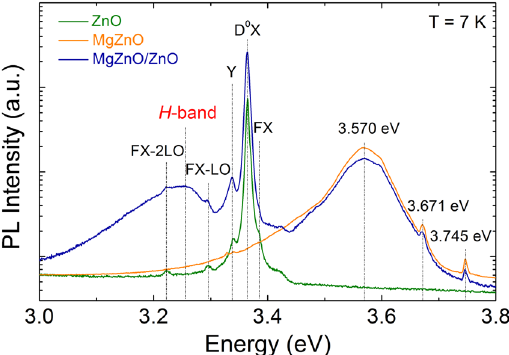
Figure 2. High-resolution PL spectra of three samples of ZnO/c-sapphire, MgZnO/c-sapphire, and MgZnO/ ZnO/c-sapphire at 7 K using a 325 nm laser excitation source. The bilayer exhibits a luminescence H -band at ~3.2 eV, which is absent in the constituent single-layer